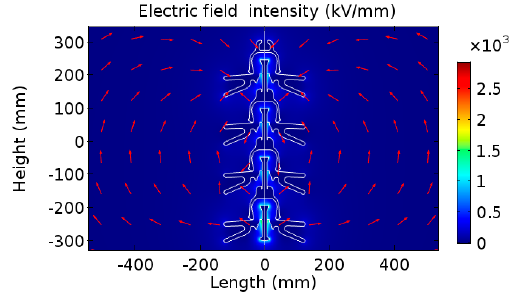
Figure 7. Electric field distribution of insulator string under clean and dry conditions.